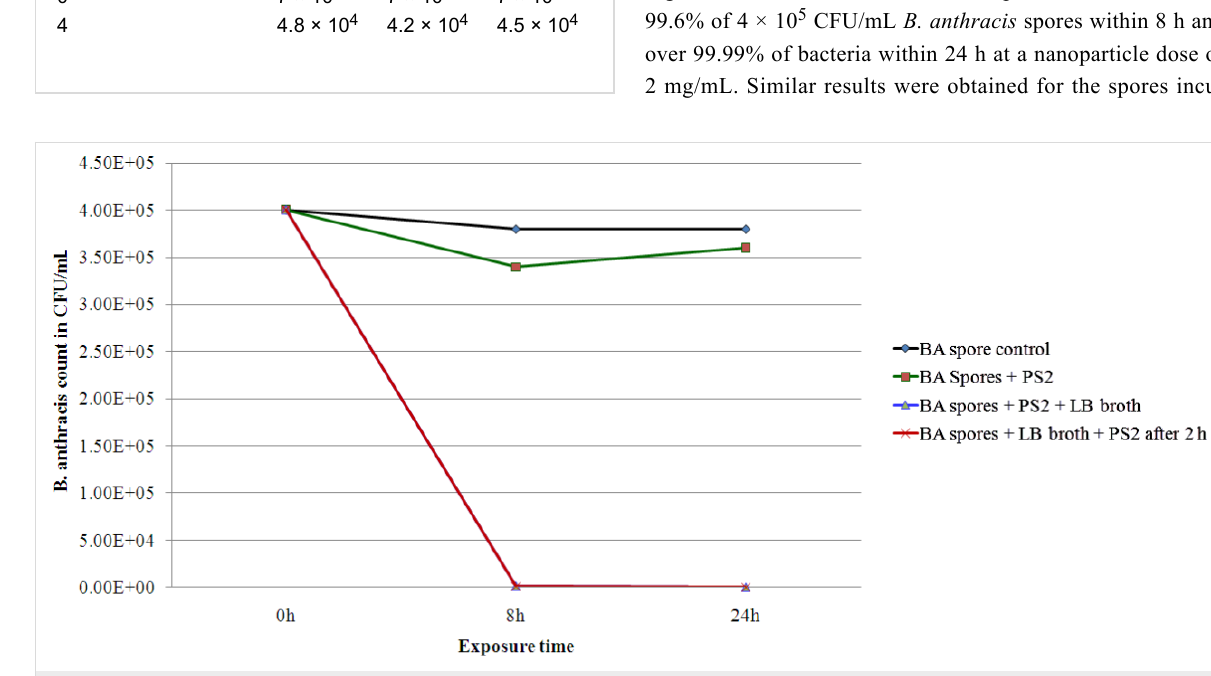
Figure 7: Antibacterial activity of CuO nanorods (PS2) against B. anthracis spores in presence and absence of growth media namely LB broth.